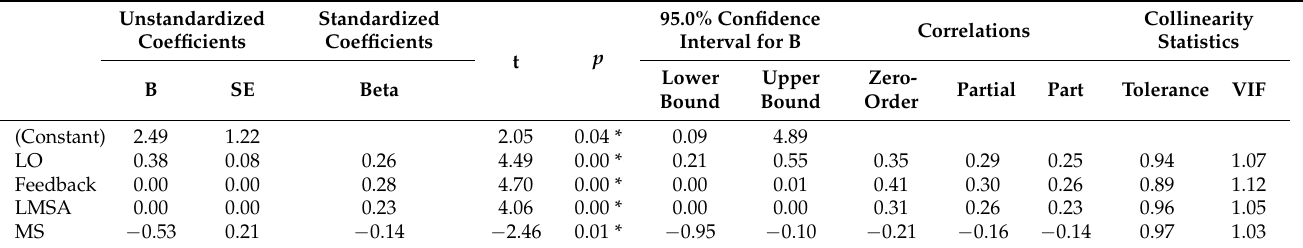
Table A1. Coefficients in the prediction of type of group (combining ALT resources) with LO, feedback, LMS access, and MS.